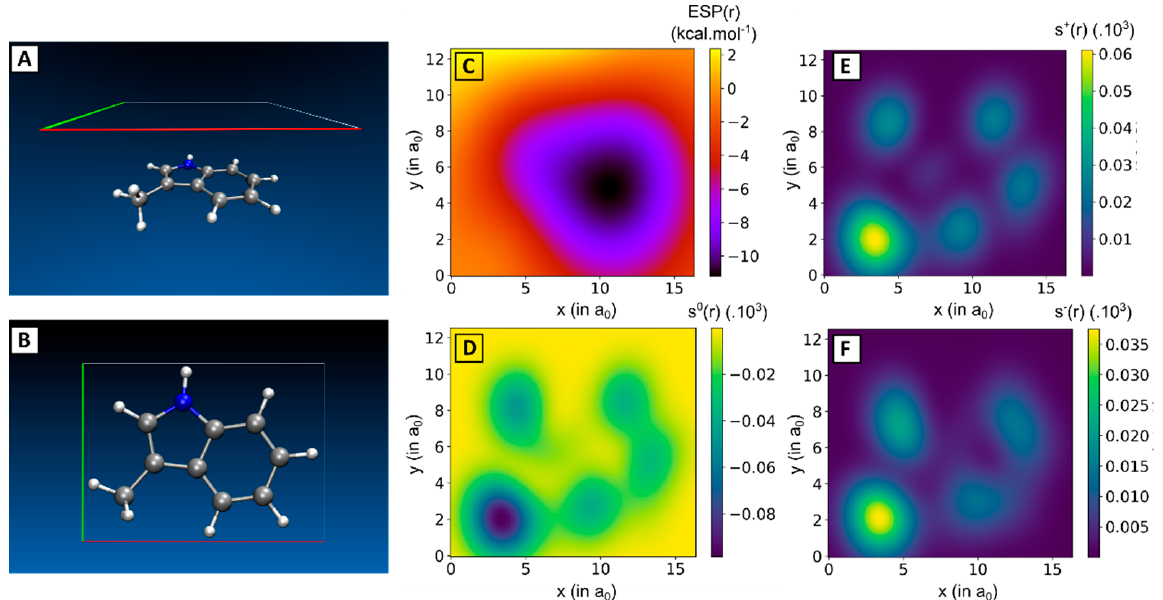
Figure 5. ( A ) Side- and ( B ) top-view of 3-methylindole together with a plane situated parallel and 3.25 Å above the ring scaffold. ( C ) Local electrostatic potential (ESP( r )), ( D ) local softness indices for radical attack (s 0 ( r )), ( E ) nucleophilic attack (s + ( r )) and ( F ) electrophilic attack (s - ( r )) are computed in this plane. Local softness indices values (in a.u.) are multiplied with a factor 10 3 .